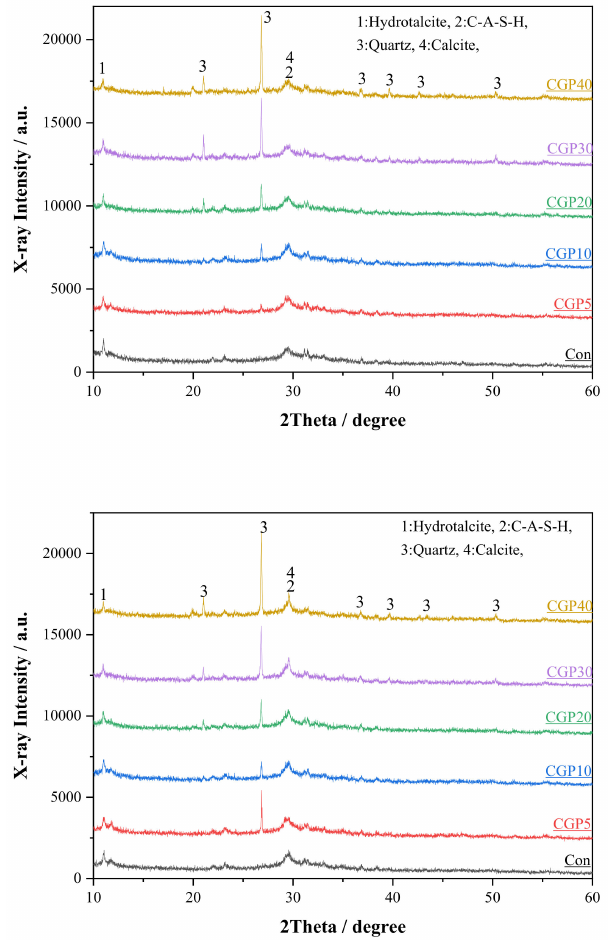
Figure 4. XRD spectra of AAC: 3 d and 28